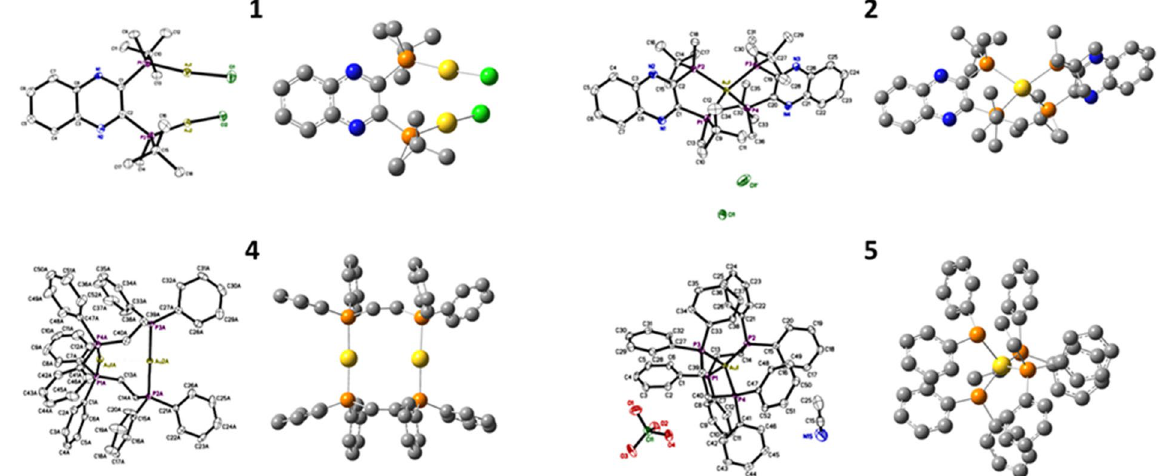
Figure 5. X-ray crystal and calculated structures of 1 , 2 , 4 , and 5 . Ellipsoids are drawn at 50% probability level. Hydrogen atoms bound to carbon atoms and solvent are omitted for clarity. The structures were calculated on B3LYP/SDD, 6–31 G(d,p). No imaginary frequencies were found.